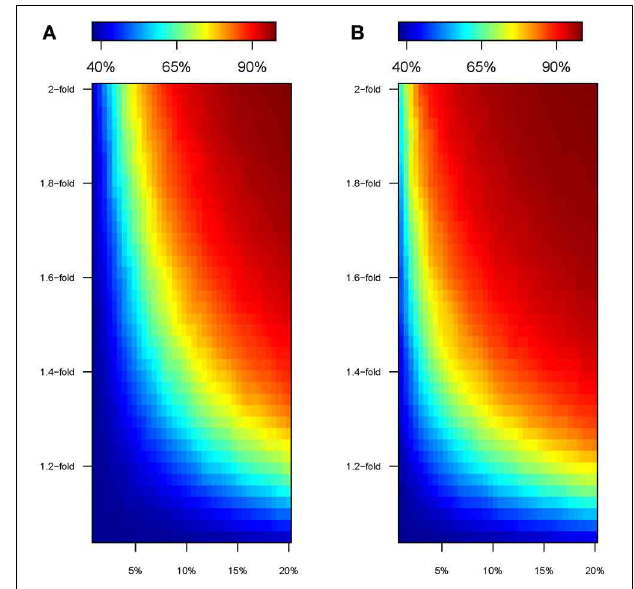
FIGURE 4 | Heritability of the simulated trait in the “modern” environment. Color map showing the heritability in cohorts perturbed under model 1 (A) and model 2 (B) , according to the percentage of SNPs perturbed (x-axis) and the factor of perturbation in effect size